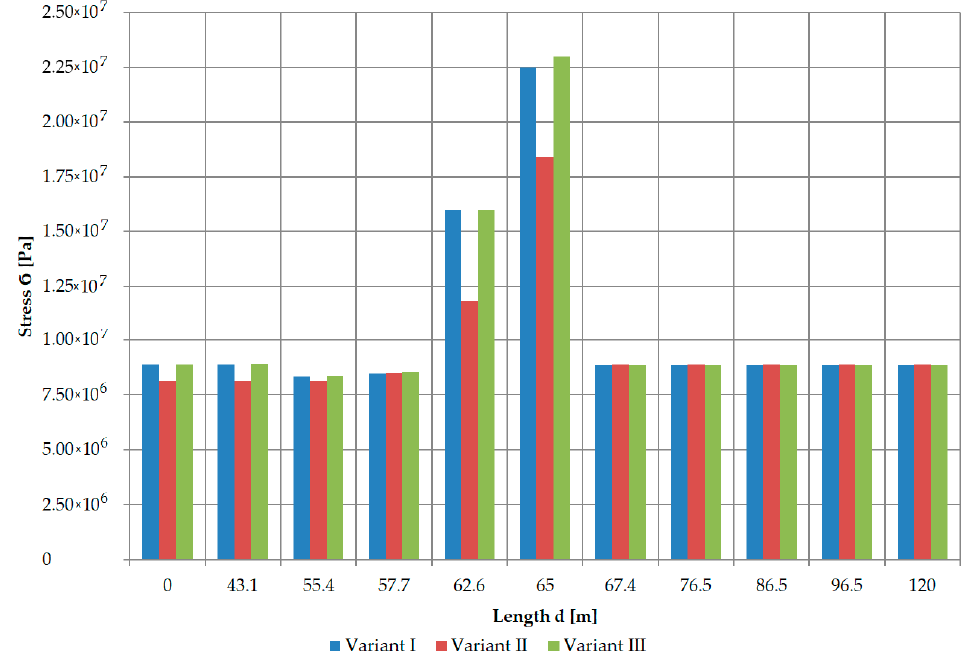
Figure 16. Stress distribution in the rock mass depending on the length of a longwall panel.